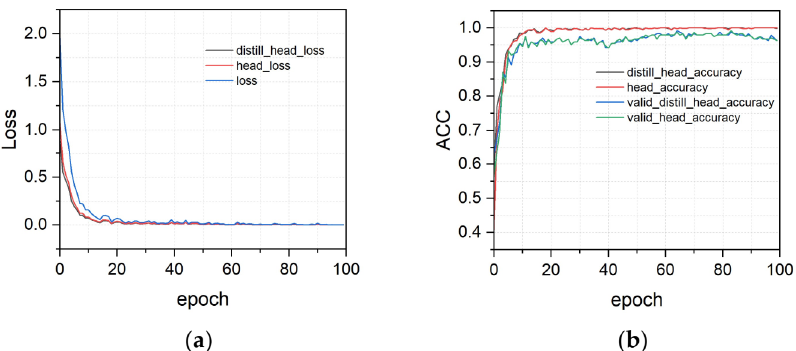
Figure 11. Training curves of GAPs. ( a ) Loss curves of two classifier heads, ( b ) Training curves of training and validation set.